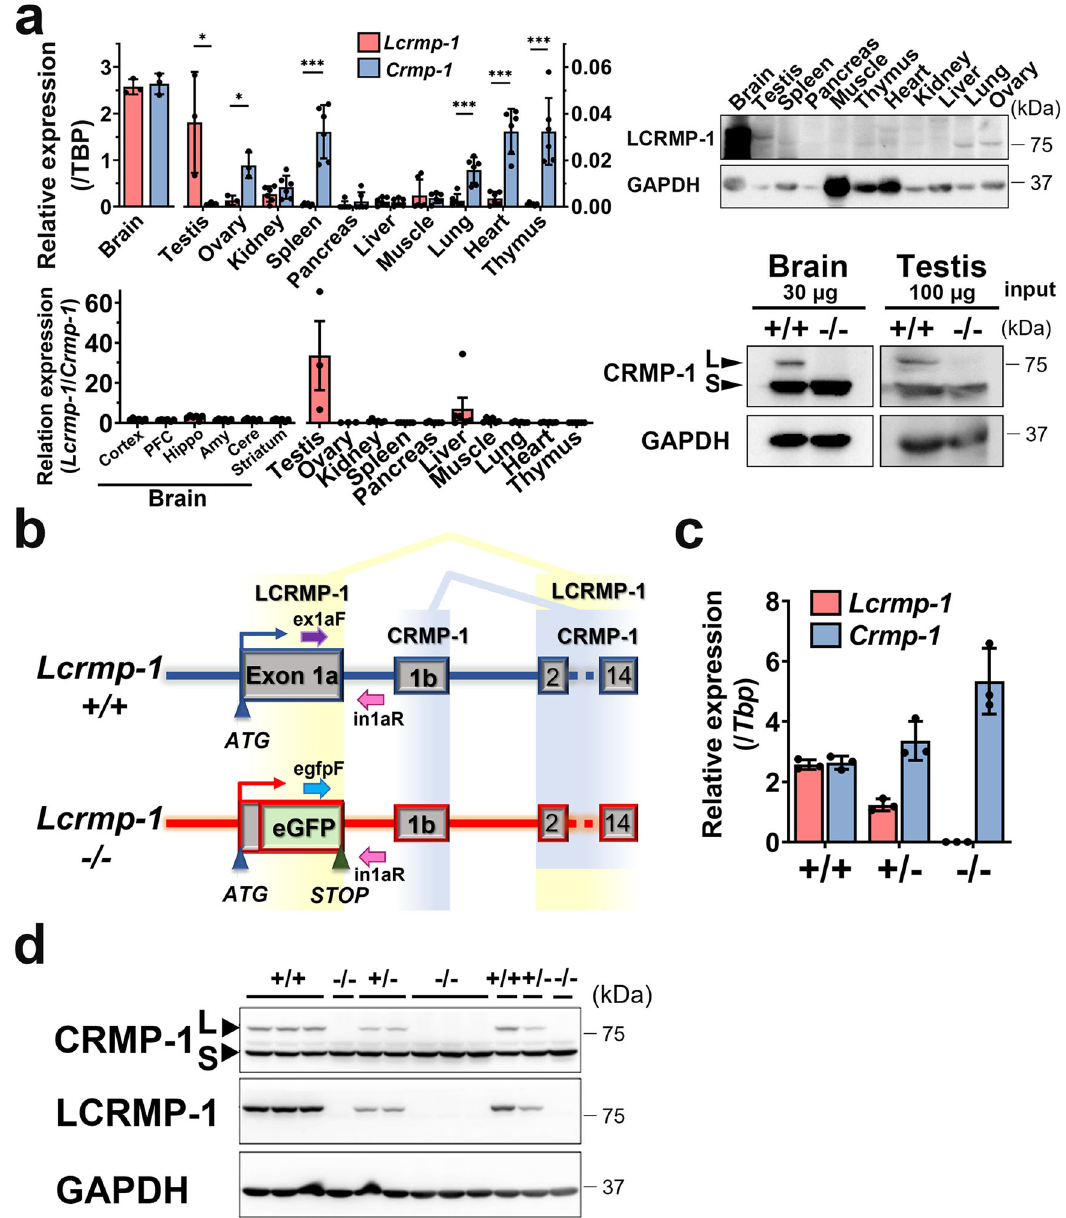
Fig. 1 Expression pro fi ling of LCRMP-1 and generation of LCRMP-1-de fi cient mice. a Upper panel: real-time qPCR analysis of LCRMP-1 and CRMP-1 mRNA expression pro fi le and Western blot analysis of LCRMP-1 protein expression pro fi le by LCRMP-1 speci fi c antibody in wild-type ( Lcrmp-1 + / + ) mice. Relative expression of qPCR was calculated as target gene/TBP. Lower panel: ratio of the relative mRNA expression (LCRMP-1/CRMP-1) ( n = 6, mean ± SD, two-tailed Student ’ s t -test, * p < 0.05, ** p < 0.01, *** p < 0.001) and Western blot analysis of LCRMP-1 and CRMP-1 protein expression by common CRMP-1 antibody. b The targeting strategy for Lcrmp-1 . Exon 1a of the Lcrmp-1 + / + allele was replaced with a target vector composed of E1a-eGFP (enhanced green fl uorescence protein). Ex1aF and in1aR primer sets were used to detect the Lcrmp-1 + / + allele, and egfpF and in1aR primer sets for the Lcrmp-1 − / − allele. c Expression levels of LCRMP-1 and CRMP-1 mRNA in brain lysate from Lcrmp-1 + / + , Lcrmp-1 + / − , and Lcrmp-1 − / − mice ( n = 3, mean ± SD). d Expression levels of LCRMP-1 and CRMP-1 protein in brain lysate from Lcrmp-1 + / + , Lcrmp-1 + / − , and Lcrmp-1 − / − mice. CRMP-1 has two forms: Long-form (L), is known as LCRMP-1, and short-form (S) is the same as CRMP-1. It had a dose-dependent effect on the expression of LCRMP-1. PFC prefrontal cortex, Hippo hippocampus, Amy amygdala, Cere